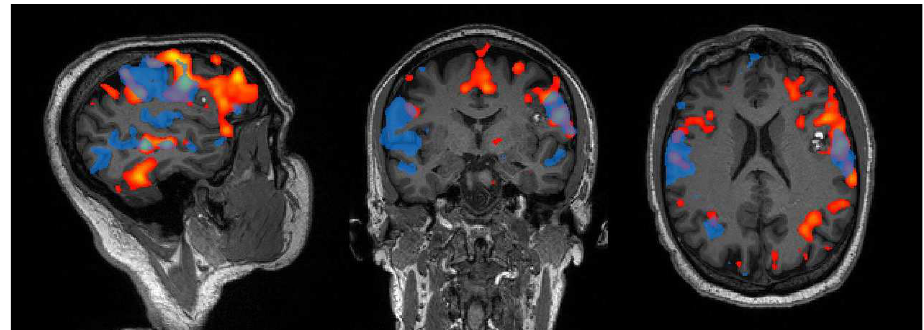
Figure 2. Example of the language network retrieved from a patient with left inferior frontal caver- noma, using a phonemic fluency task (red) and resting-state (blue) fMRI. For the latter, a 10 min-long multiband resting-state fMRI sequence with TR = 0.735 was acquired on a 3T Siemens Magnetom Skyra scanner (IRCCS Istituto delle Scienze Neurologiche di Bologna), and the network localization was performed using ICA with dimension = 30. With respect to task, the resting-state fMRI network exhibits wider activations on the contralateral side (right), yet less extended on the lesioned one (left), especially in the frontal